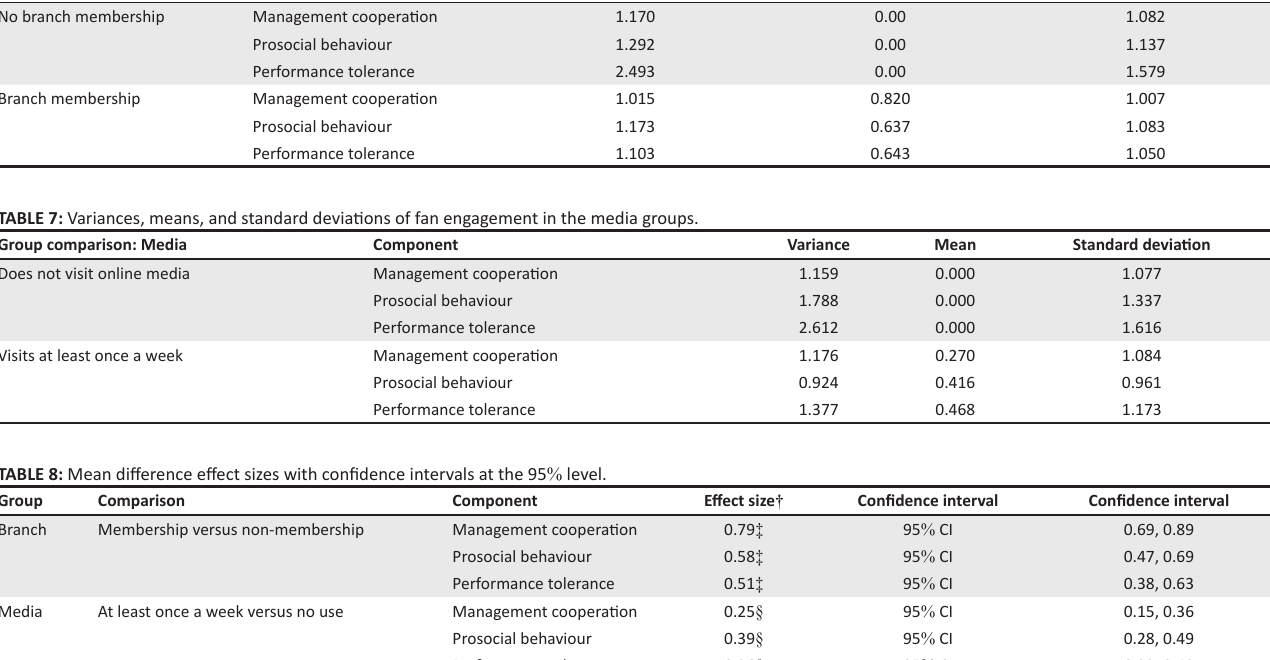
TABLE 6: Variances, means, and standard deviations of fan engagement in the branch groups. Group comparison: Branch